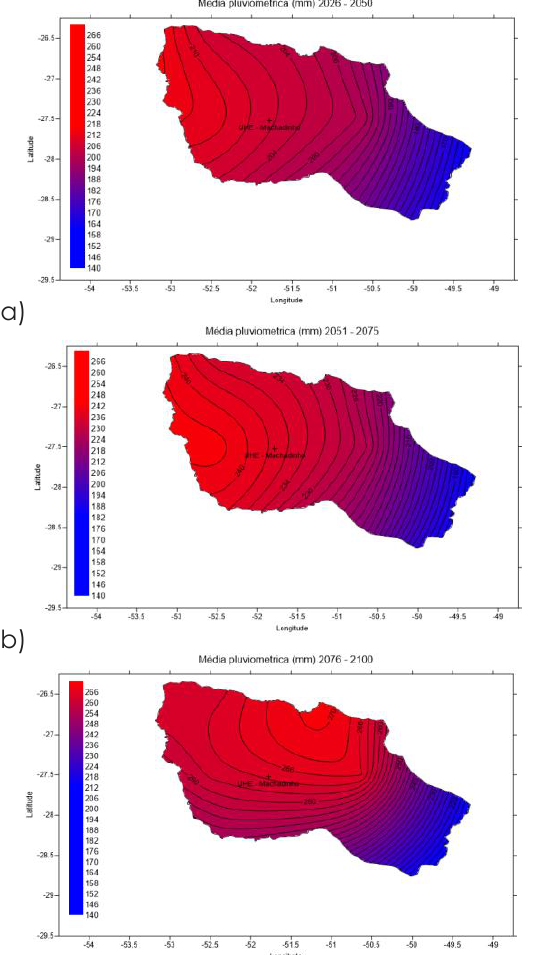
Figure 5. Precipitation projections: a) Scenario 1 (2026 - 2050; b) Scenario 2 (2051 - 2075); C) Scenario 3 (2076 -